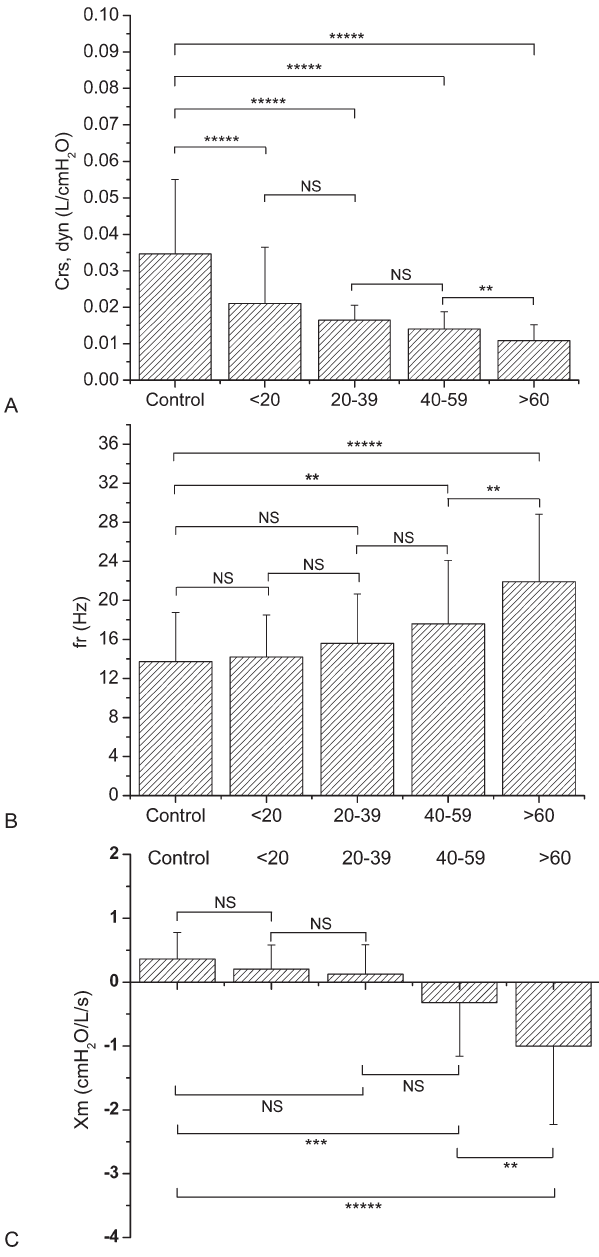
Figure 2 - Effect of the increase in pack-years on reactive parameters. (A) The dynamic compliance (Crs,dyn) decreased. (B) The resonance frequency (fr) increased. (C) The mean reactance (Xm) values were